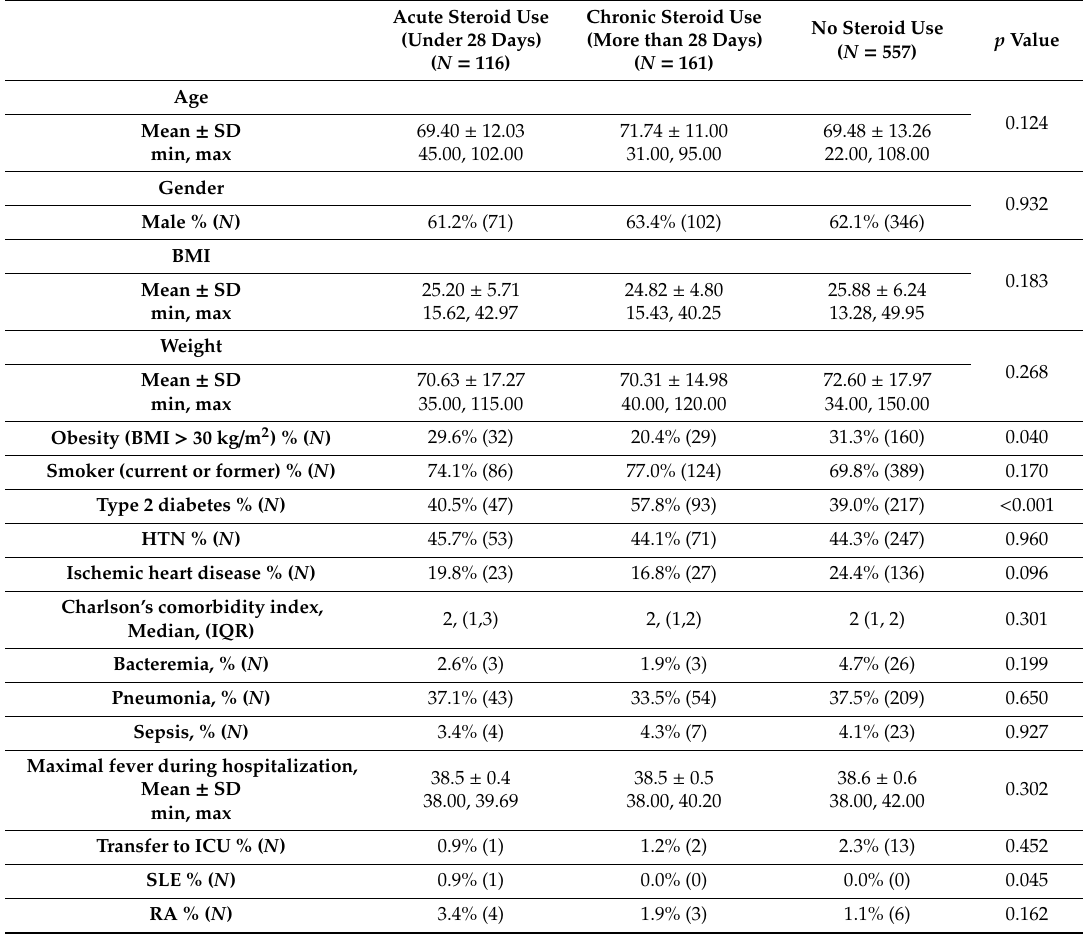
Table 1. Population